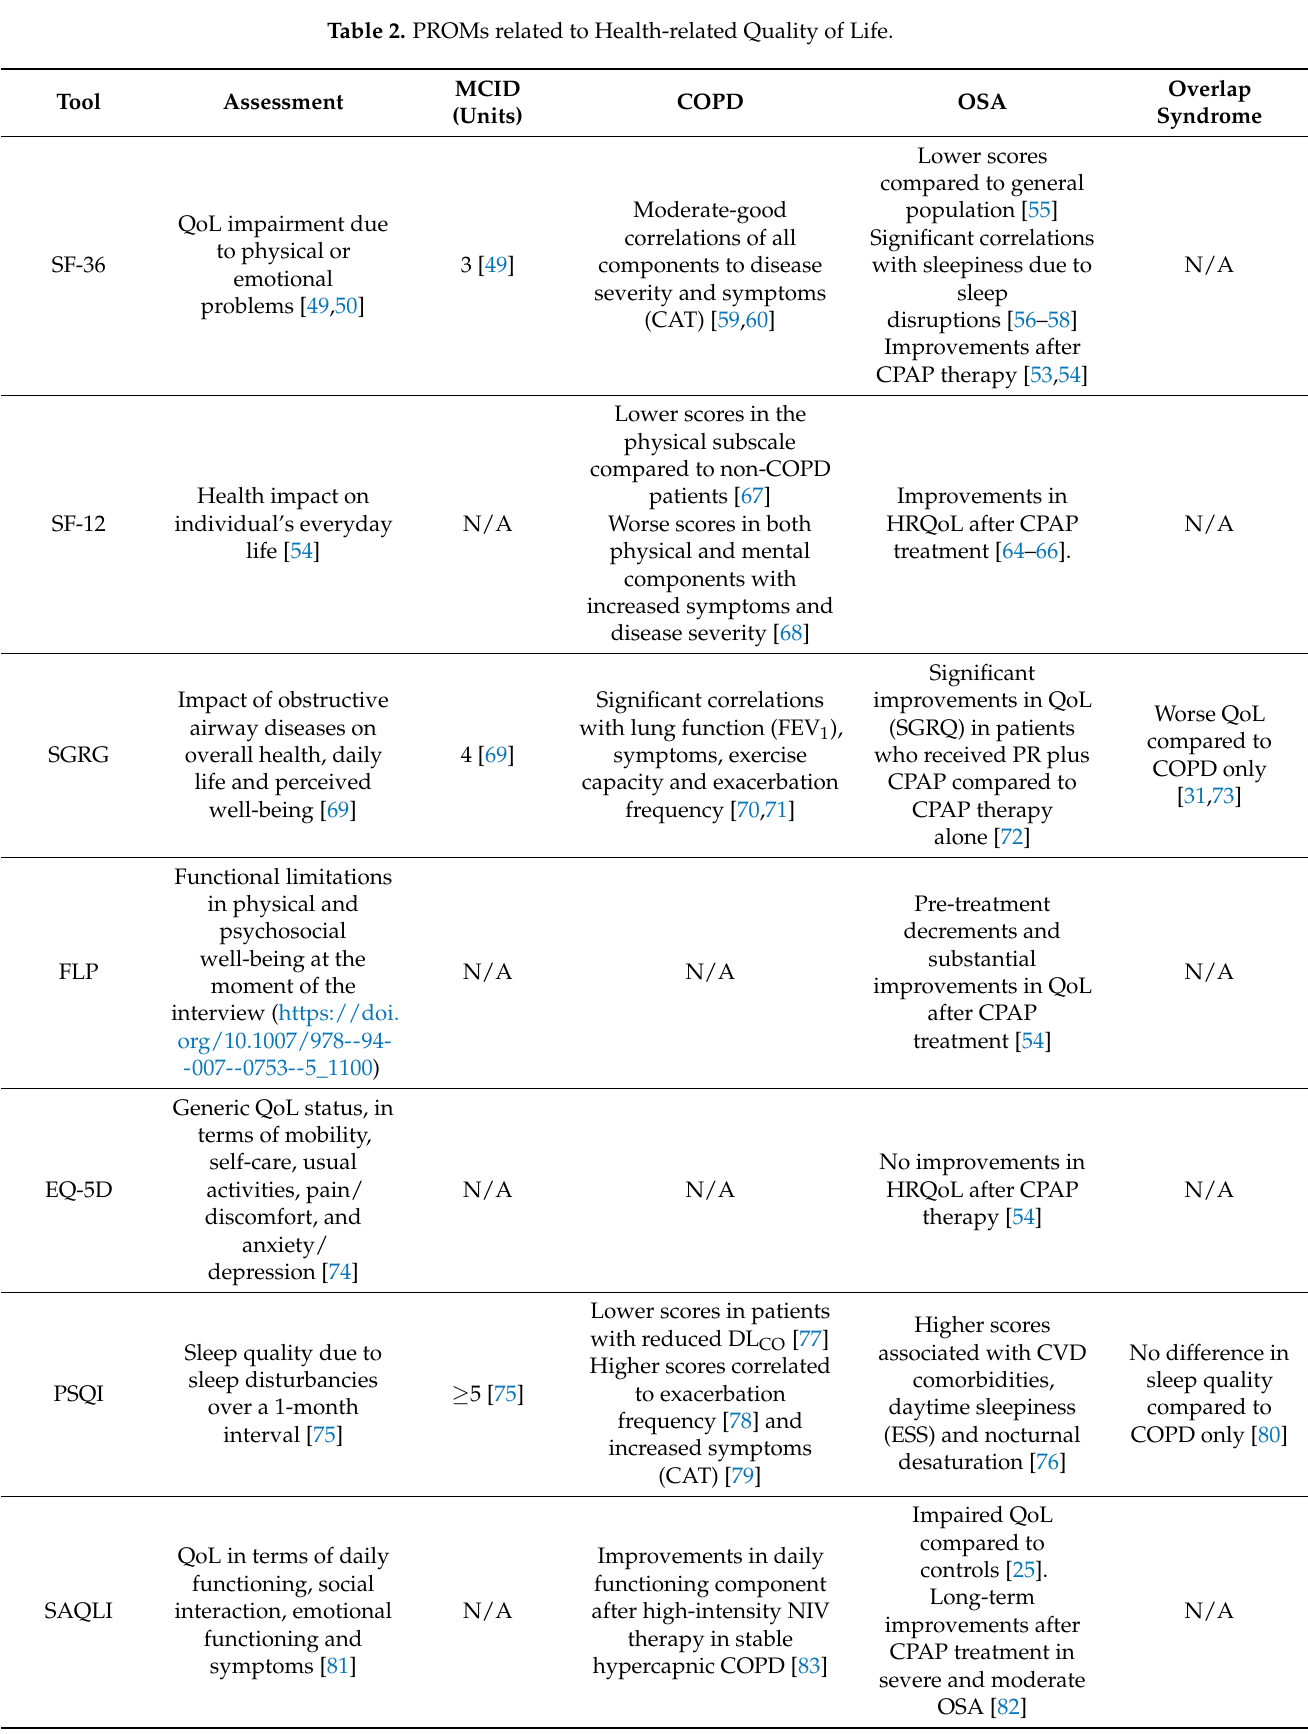
Table 2. PROMs related to Health-related Quality of